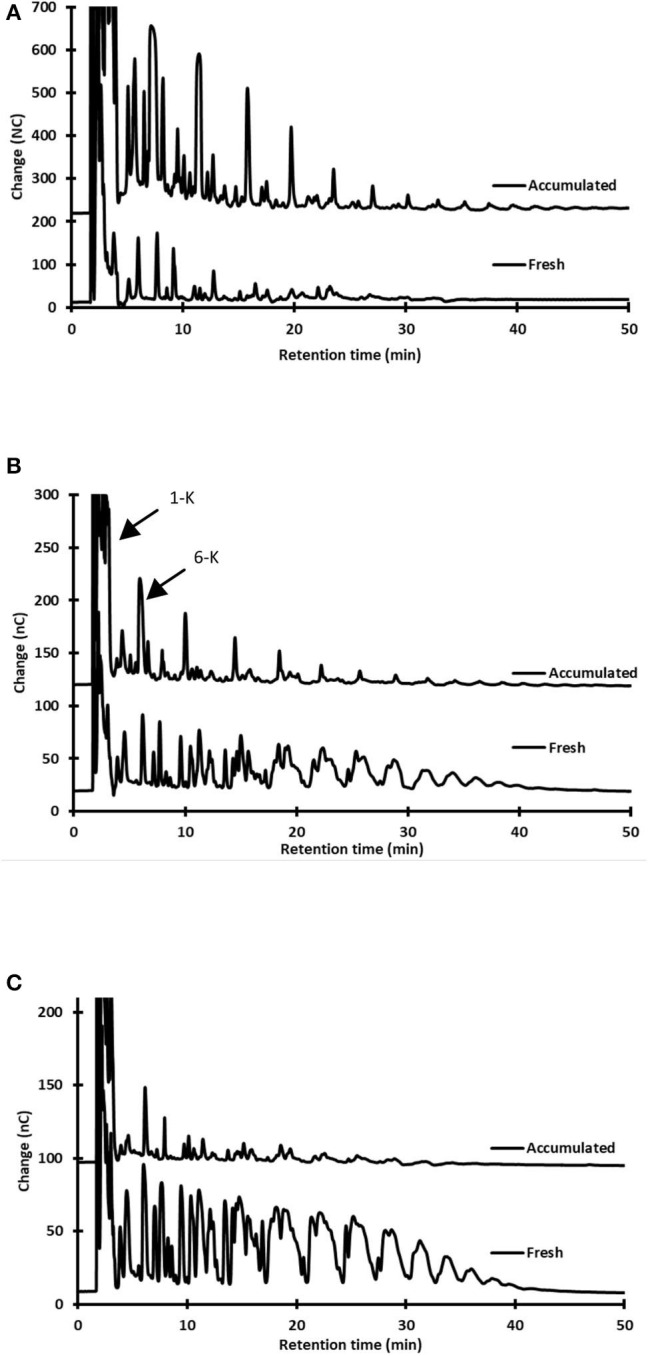
Examples of the three different FOS profiles observed in accumulated aguamiel. HPAEC-PAD oligosaccharide profiles in fresh (immediately after scraping) and accumulated (10 h) aguamiel. (A) Type 1. Synthesis of oligosaccharides: A. mapisaga in the early productive stage (B) Type 2. Agavin-like profile and synthesis of new oligosaccharides: A. mapisaga in intermediate-late productive stages, and (C) Type 3. Fructan dilution, A. mapisaga in an intermediate-late productive stage. See explanation in the text.